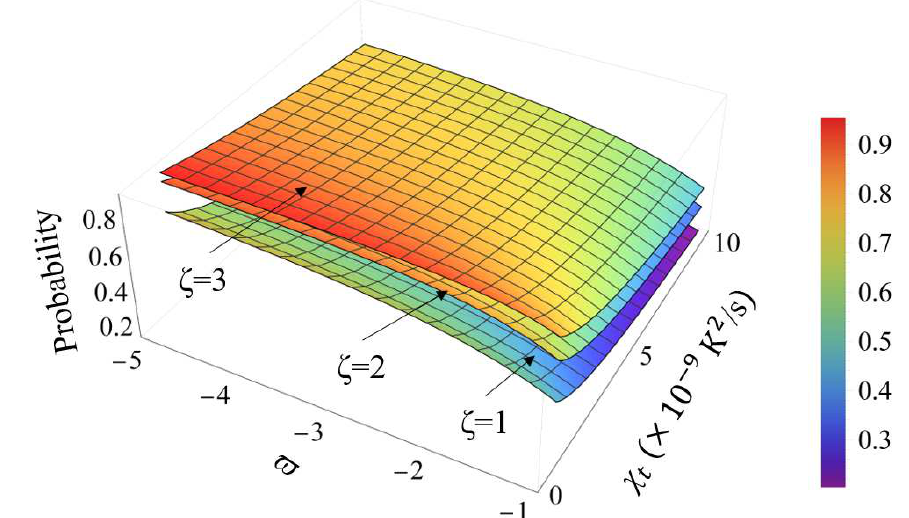
Figure 6. The normalized transmitting probability of the signal OAM modes versus temperature-salinity contribution ratios (cid:118) , dissipation rate of the mean-squared temperature χ t and an-isotropic factor of turbulence ζ